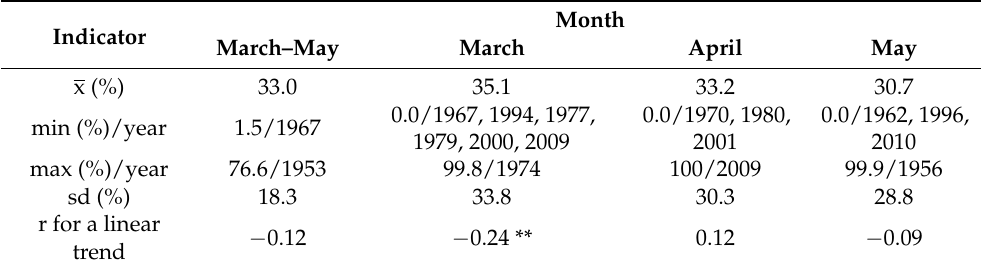
Figure 7. Area of the country covered by spring precipitation deficits (calculated as a three-month average: March, April and May) in 1951–2018. Table 2. Characteristics of the area covered by spring (March–May) precipitation deficits. Years